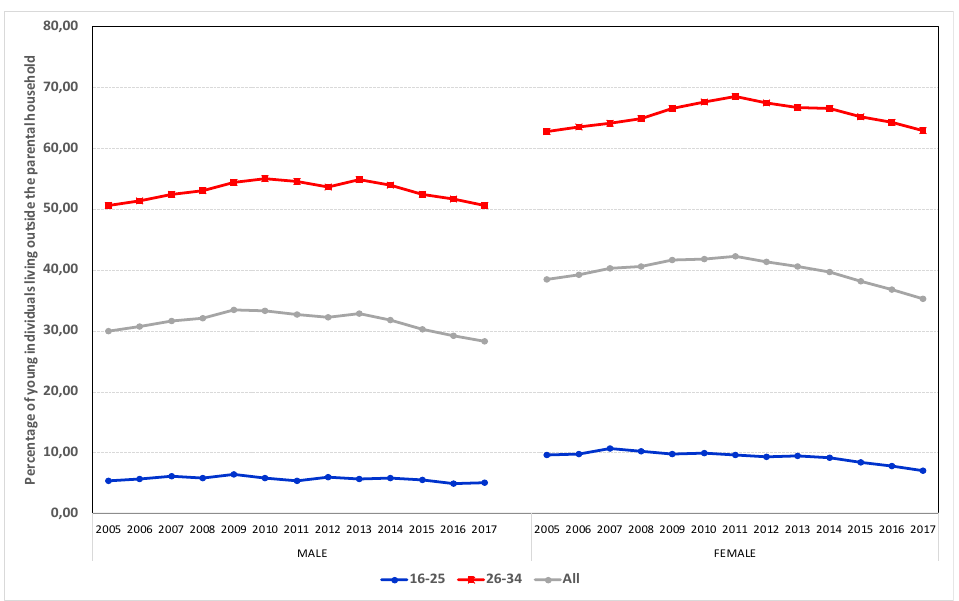
Figure 5 : Percentage of young individuals living outside the parental household